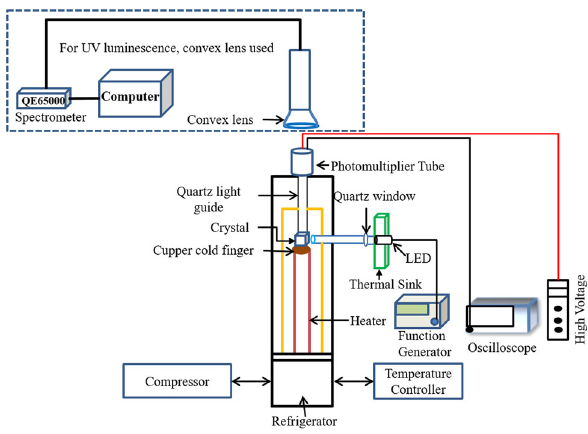
Fig. 2 A Schematic diagram of the low temperature setup for lumi- nescence decay time and light yield